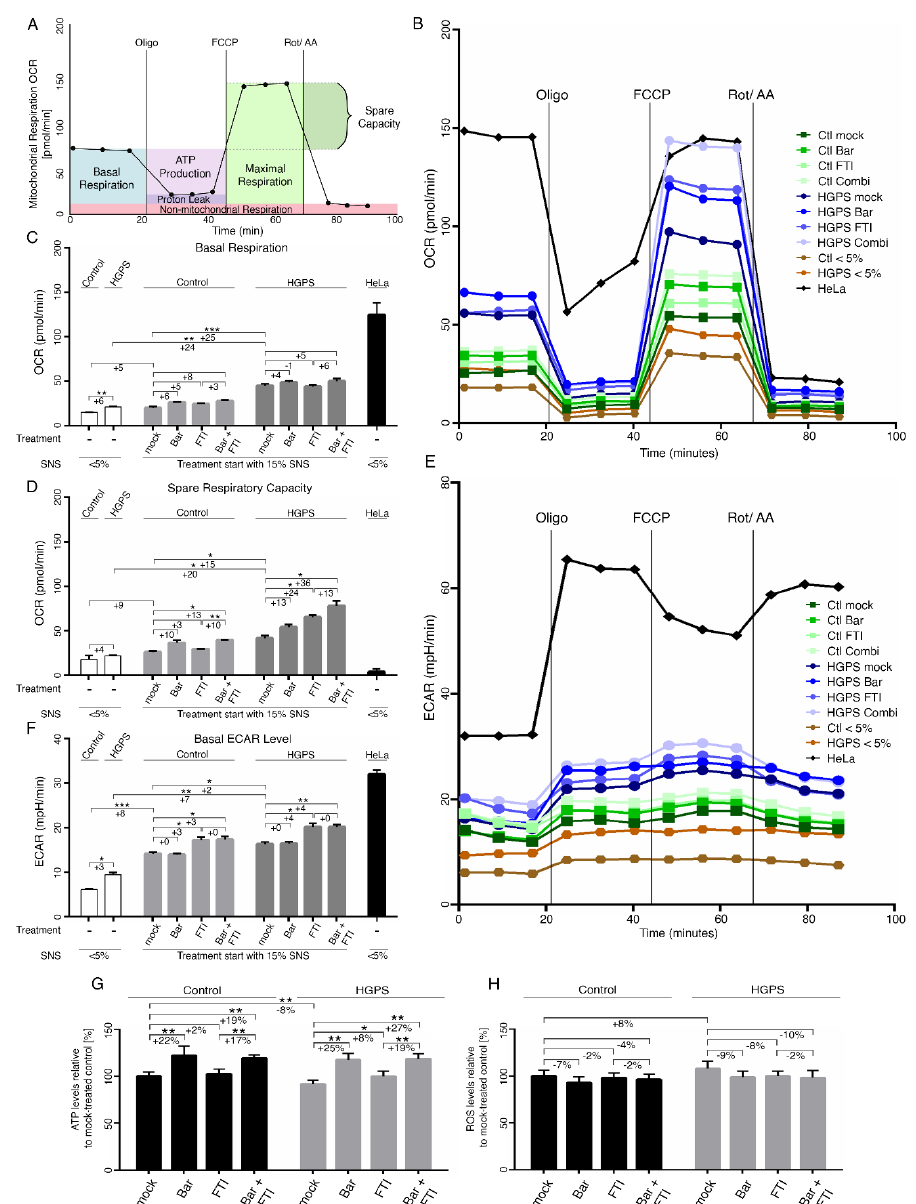
Figure 6. Mitochondrial function and glycolysis are impaired in HGPS fibroblasts. ( A ) Schematic representation of Seahorse XF Cell Mito stress test and calculated values are indicated. Oxygen consumption rates (OCR) ( B ) and extracellular acidification (ECAR) ( E ) were determined with a Seahorse XF96 Flux analyzer in basal and stimulated conditions ( n = 3). Additional parameters like basal respiration ( C ), spare respiratory capacity ( D ), and basal ECAR levels ( F ) were calculated with Wave software v2.6.1.53 (Agilent Technologies, Santa Clara, CA, USA). ( G ) Cellular ATP levels were measured using a CellTiter-Glo luminescence ATP assay. ( H ) Intracellular ROS levels were determined by measuring oxidized dichlorofluorescein (DCF) levels using a DCFDA cellular ROS detection assay ( n = 3). Graphs show mean ± SD. (* p < 0.05, ** p < 0.01, *** p < 0.001)